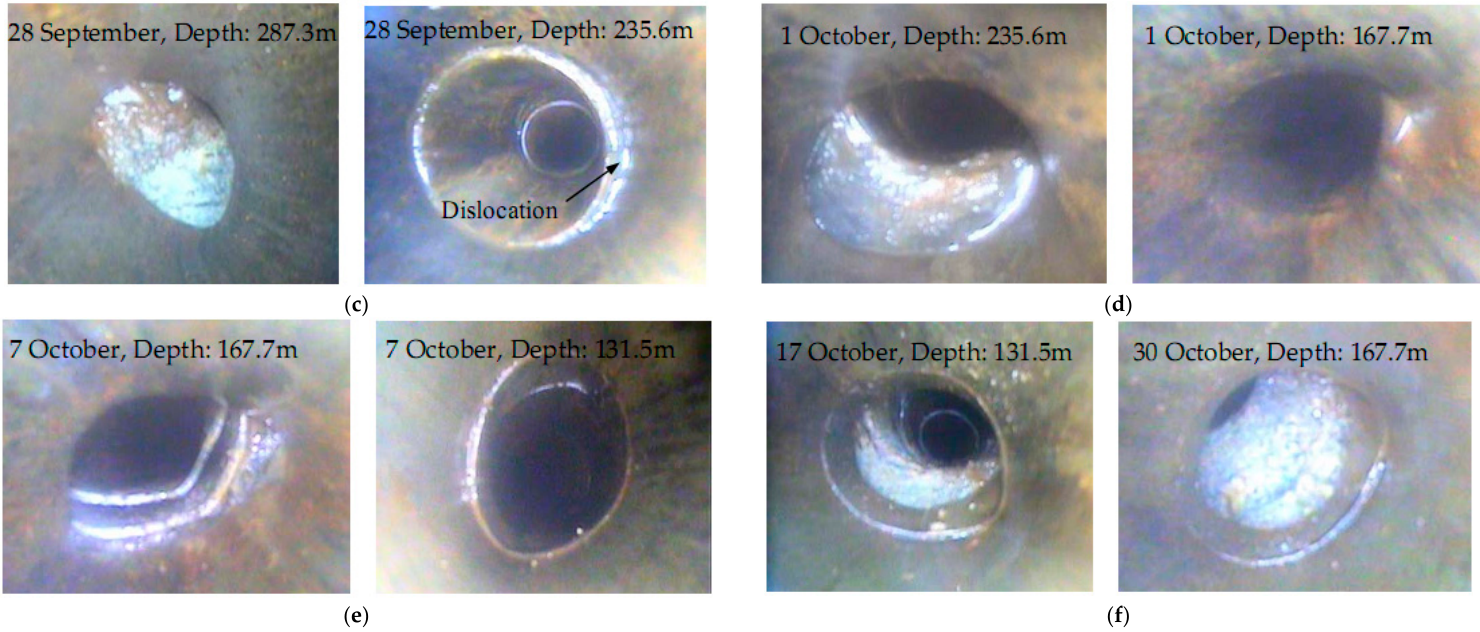
Figure 5. Field observation results of the surface borehole deformation. ( a ) Variation of the surface borehole wall deformation with working face advancing; ( b ) Intensified spalling of borehole wall with water accumulation at the depth of 361.3 m; ( c ) Borehole deformation on 28 September; ( d ) Borehole deformation on 1 October; ( e ) Borehole deformation on 7 October; ( f ) Borehole deformation on 30 October.